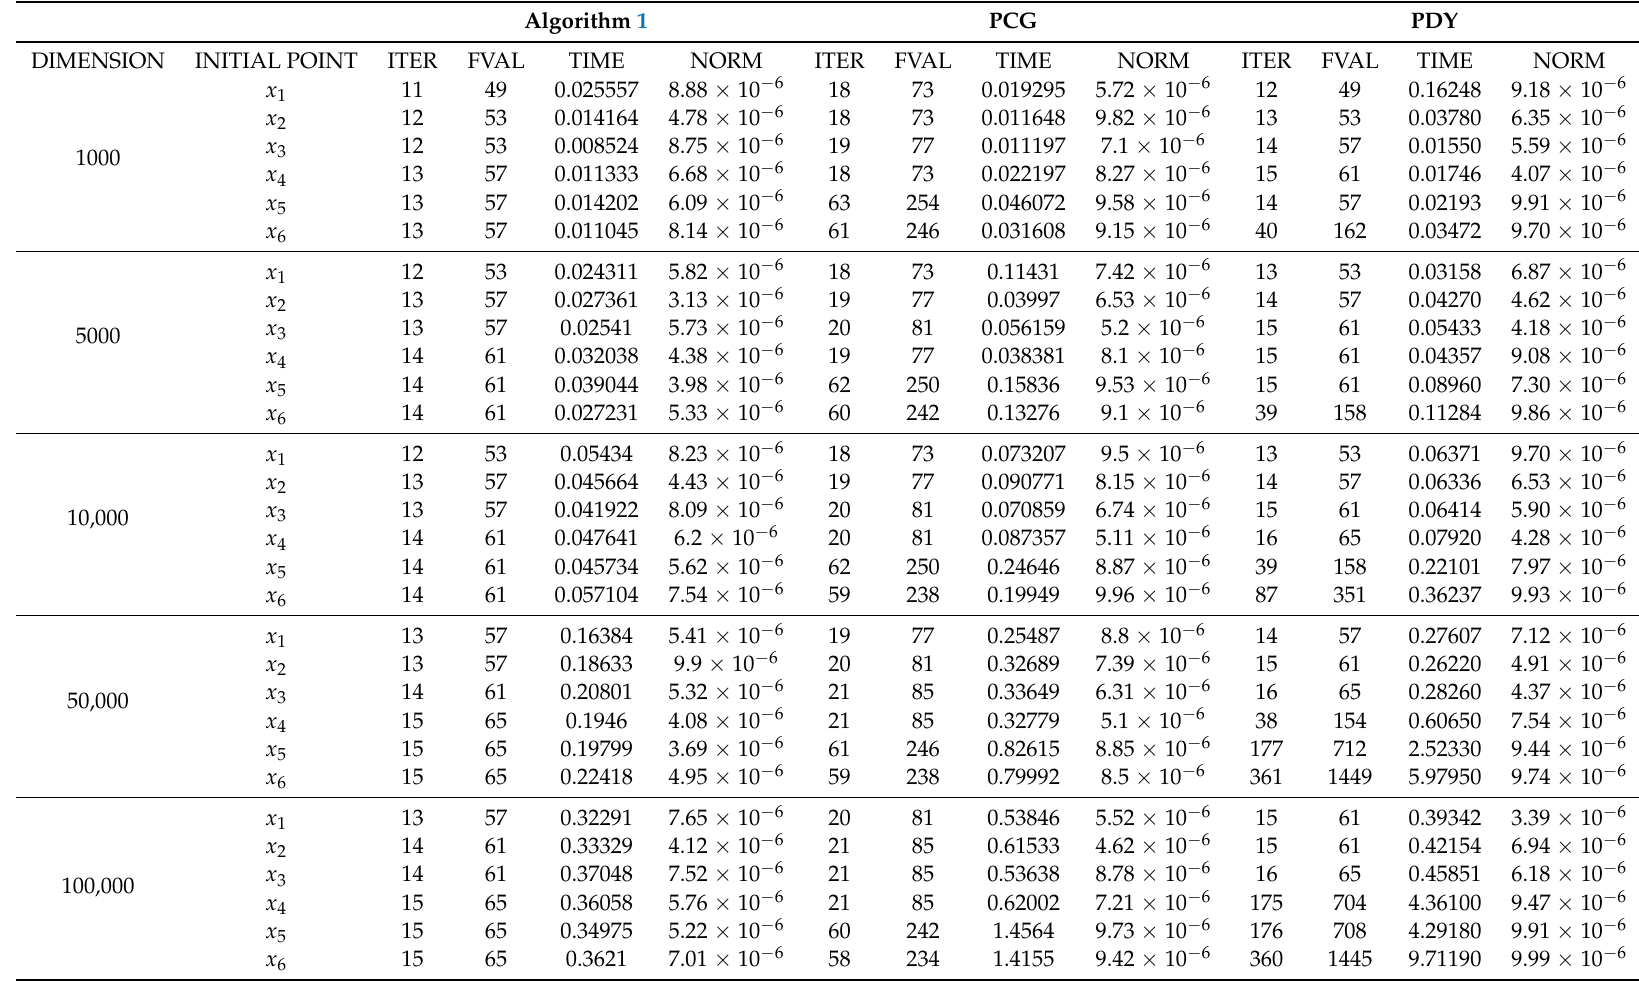
Table 1. Numerical Results for Algorithm 1 (DCG) , PCG and PDY for Problem 1 with given initial points and